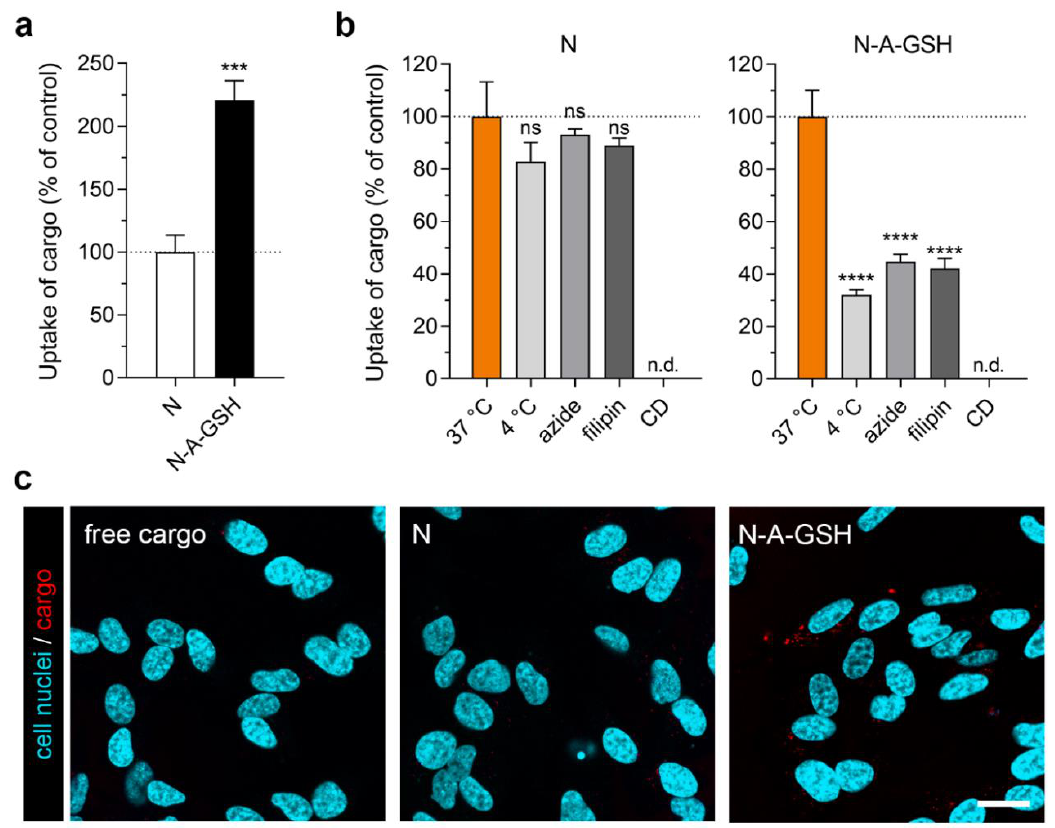
Figure 7. Cellular uptake of niosome cargo in differentiated SH-SY5Y neuronal cells after 4 h of incubation. ( a ) Uptake of cargo loaded in non-targeted (N) and alanine-glutathione targeted (N-A-GSH) niosomes. Values presented are means ± SEM. Statistical analysis: unpaired t test; *** p < 0.001; n = 6. ( b ) Effect of temperature and treatment with sodium-azide (1 mg/mL) or filipin (5 µg/mL) on the cellular uptake of cargo. The effect of cytochalasin D (CD) could not be determined (n.d.; see text). Values presented are means ± SEM. Statistical analysis: one-way ANOVA followed by Dunnett’s posttest; **** p < 0.0001, ns: not significant ( p > 0.05) compared to the first column of each niosome group; n = 6. ( c ) Live cell visualization of cargo taken up by SH-SY5Y cells. Free cargo: cargo not loaded in niosomes. Bar: 25 µm.